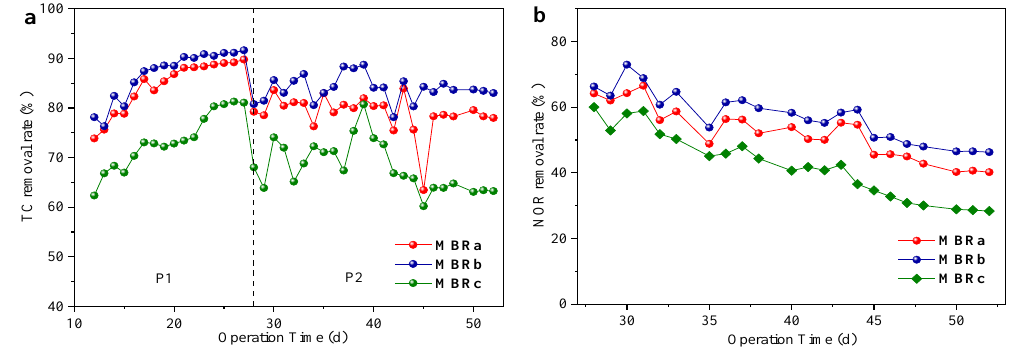
Figure 3. TC removal rates ( a ) and NOR removal rates, ( b ) in reactors at stable state in P1 and P2.